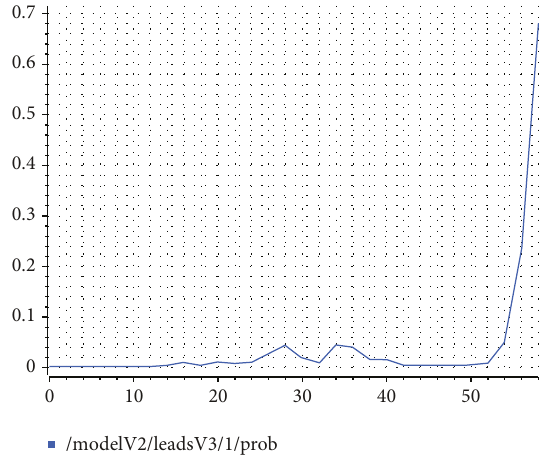
Figure 42: T2N2 lead car detection.